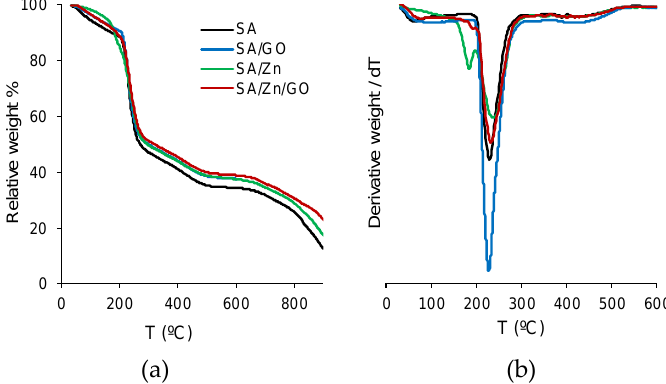
Figure 5 . Thermogravimetry results. ( a ) Relative weight loss, ( b ) temperature derivative of weight loss vs. temperature.